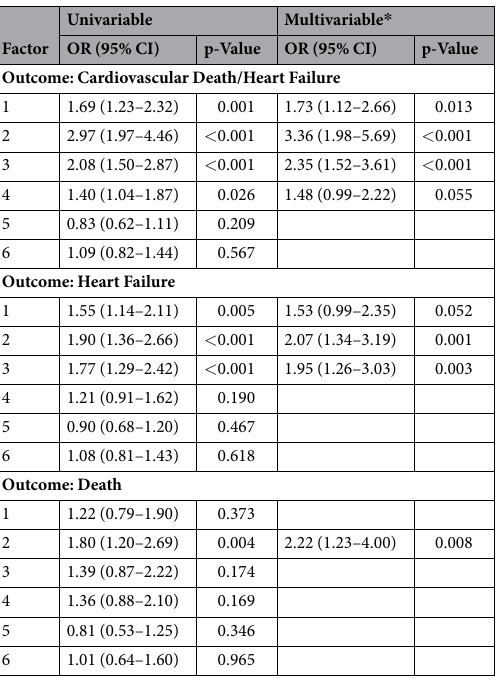
Table 2. Univariate and multivariate analyses of associations between metabolomics factors and cardiovascular outcome. Odds ratios indicate a 1-standard deviation increase in factor. * Adjusted for age, BMI, Gensini score, anterior myocardial infarction, symptom onset to reperfusion time, history of hypertension, history of diabetes, and current smoking. Any factor not listed was not significant at P ≤ 0.05. CI = confidence interval; OR = odds